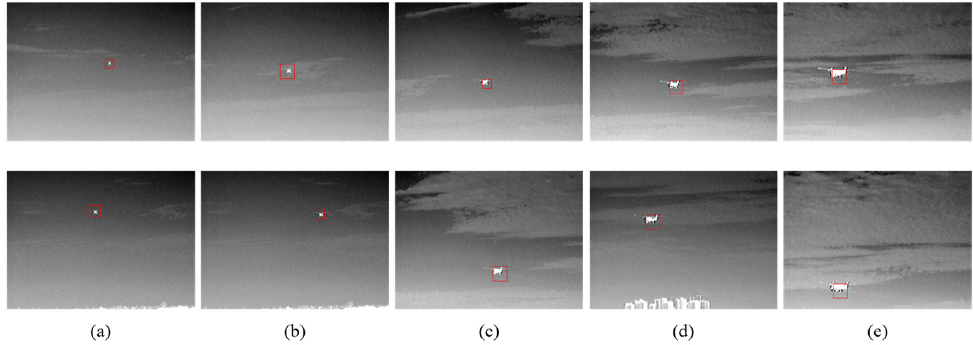
Figure 7. Detection results of two multi-scale small target sequences.